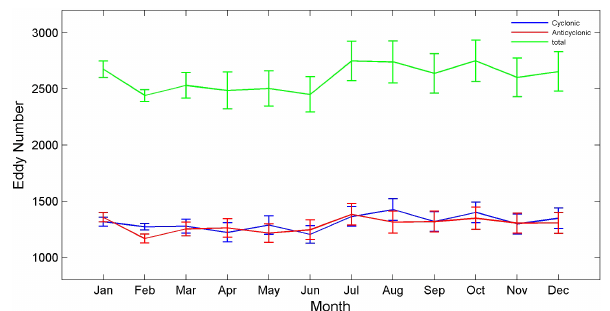
Figure 12. The number of mesoscale eddies generated in the SIO (1995–2012) as a function of the calendar months for cyclonic (blue), anticyclonic (red), and both types of eddies (green). The bars indicate the standard error of number of eddies. Mesoscale eddy data come from Chelton et al. (2011) based on altimetry observations of SSH. Chelton and Schlax have updated and ex- tended the eddy data set to April 2012 in the new third version